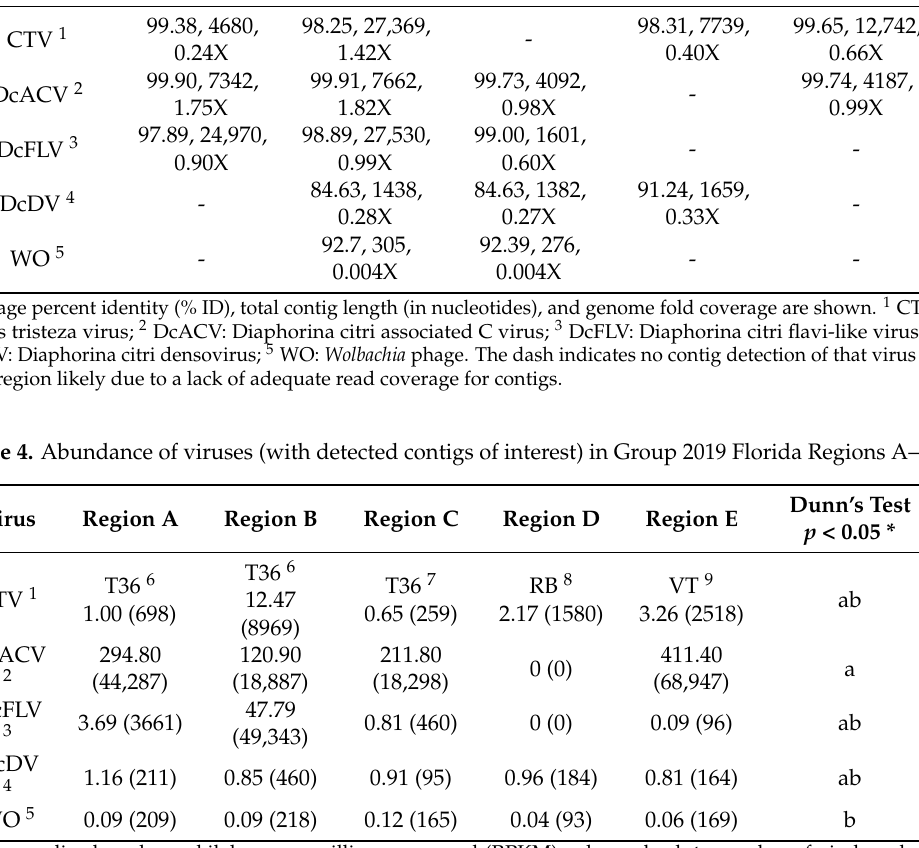
Table 3. Viral contigs annotated as known viruses of interest for 2019 Florida Regions A–E. Virus